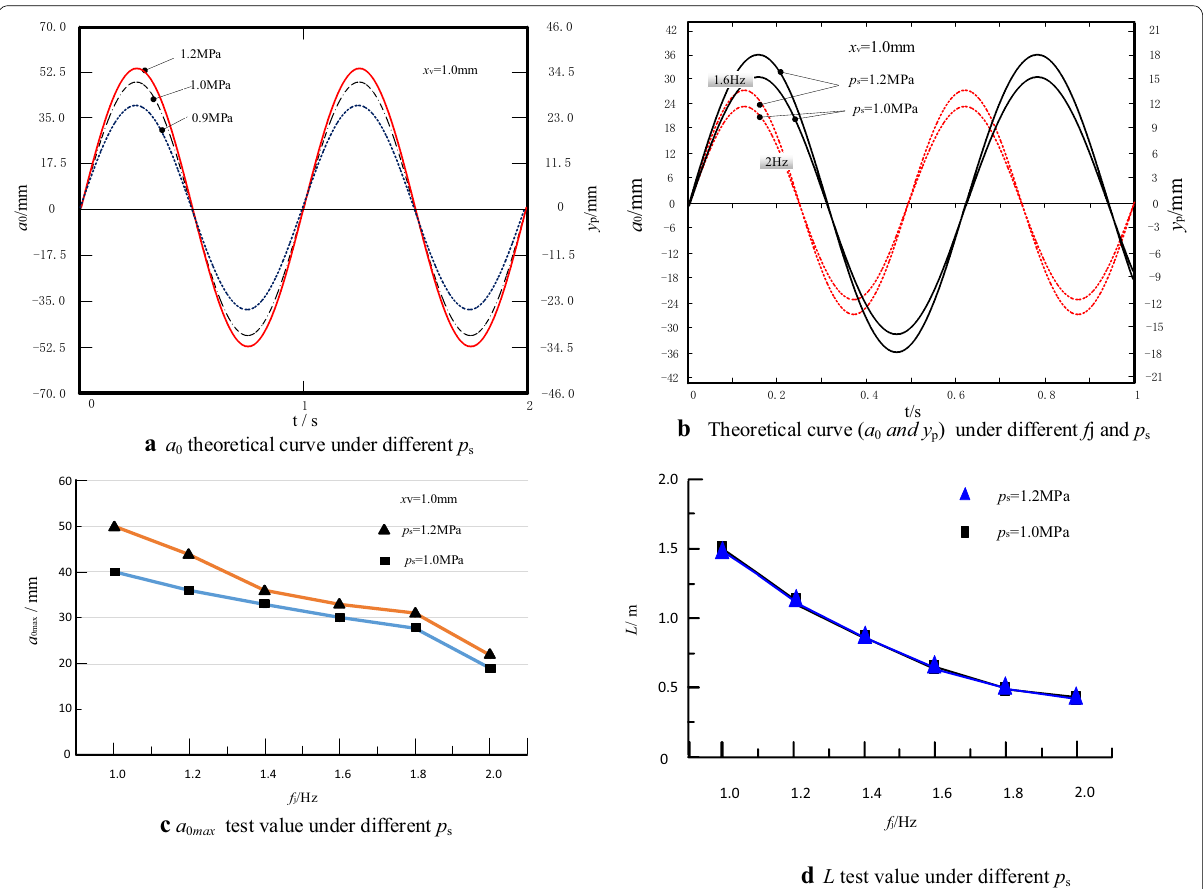
Figure 8 Influence of different p s and f j